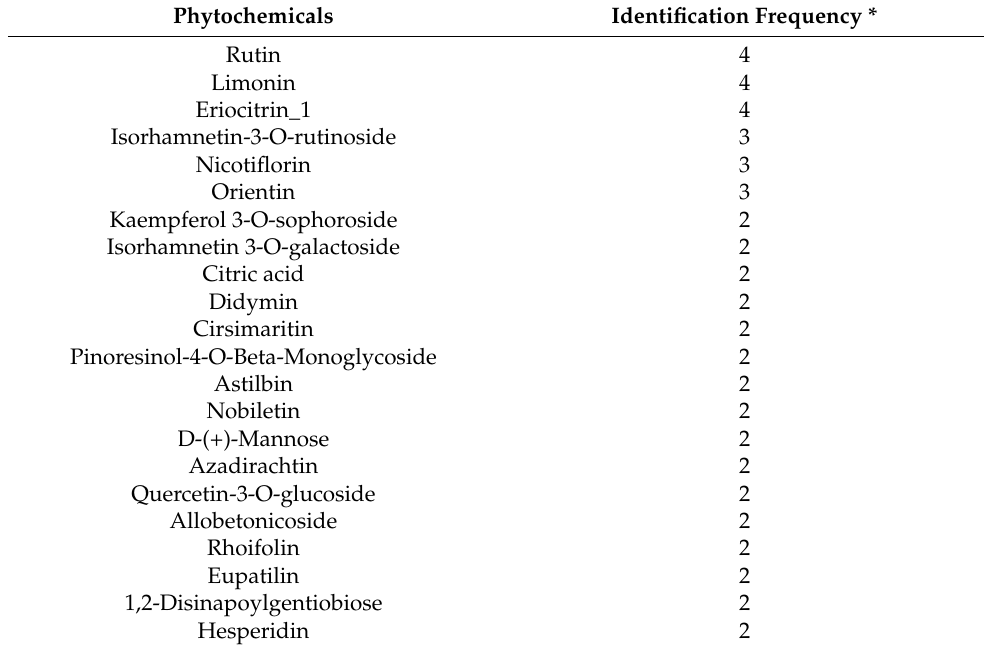
Table 5. Most common, by count, antioxidants identified in the Rutaceae family of studied plant materials. Phytochemicals